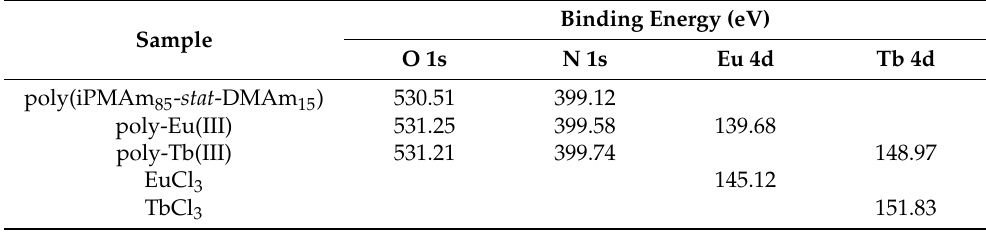
Figure 4. XPS profiles of ( a ) poly(iPMAm 85 - stat -DMAm 15 ), poly-Eu(III), poly-Tb(III),and ( b ) EuCl 3 , TbCl 3 . Table 1. Binding energy of O 1s, N 1s, Eu 4d and Tb Table 1. Binding energy of O 1s, N 1s, Eu 4d and Tb 4d.